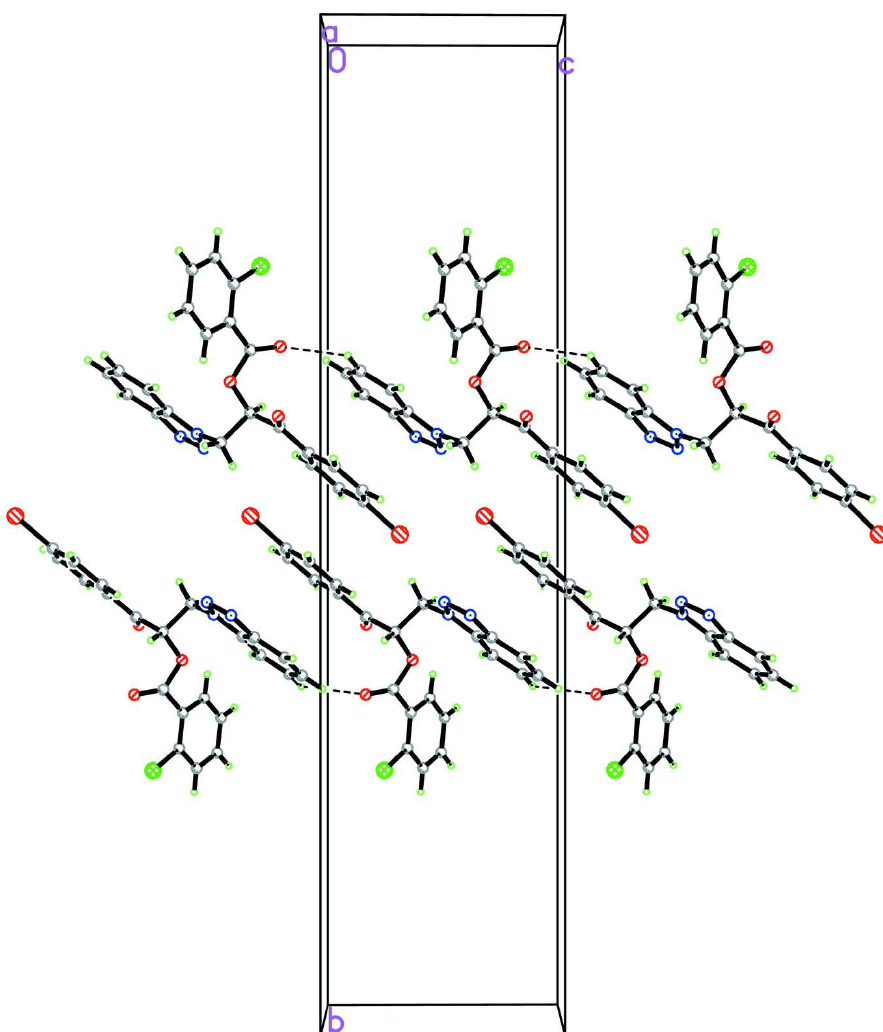
A packing diagram, viewed down the a axis. Hydrogen bonds are indicated by dashed